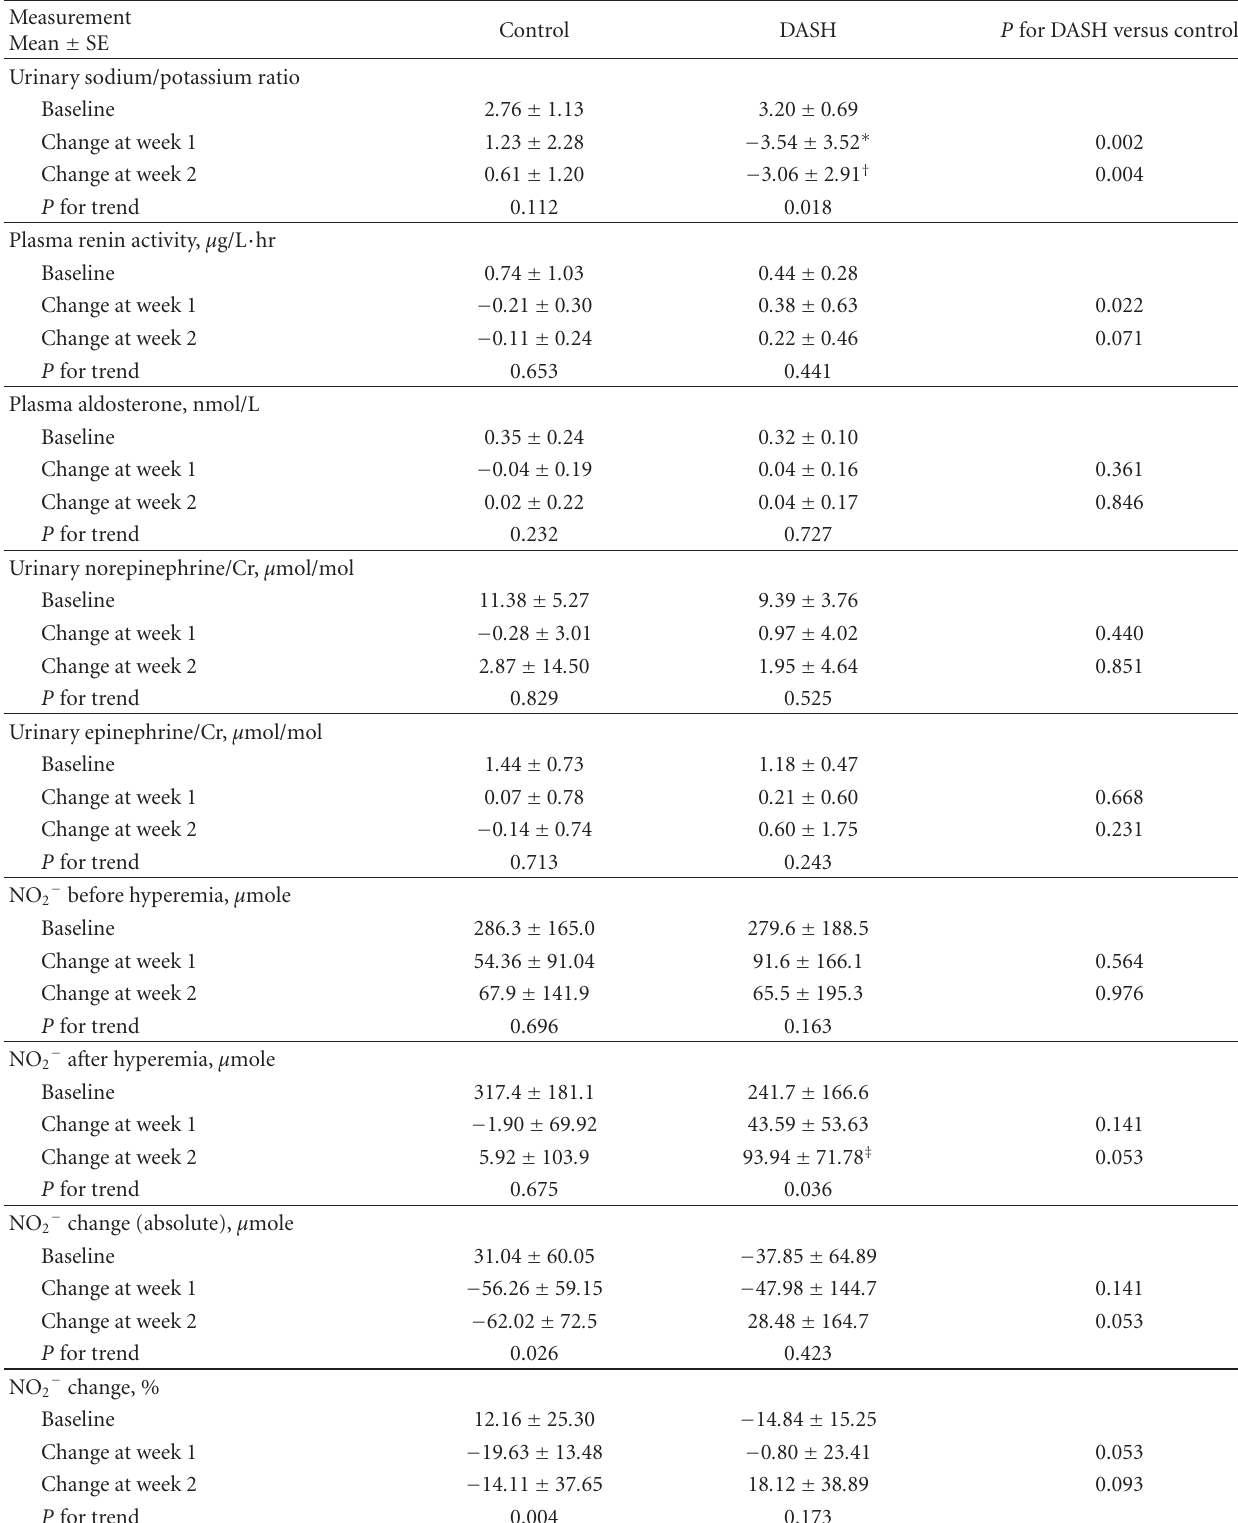
Table 4: Measures of potential mechanisms by treatment and